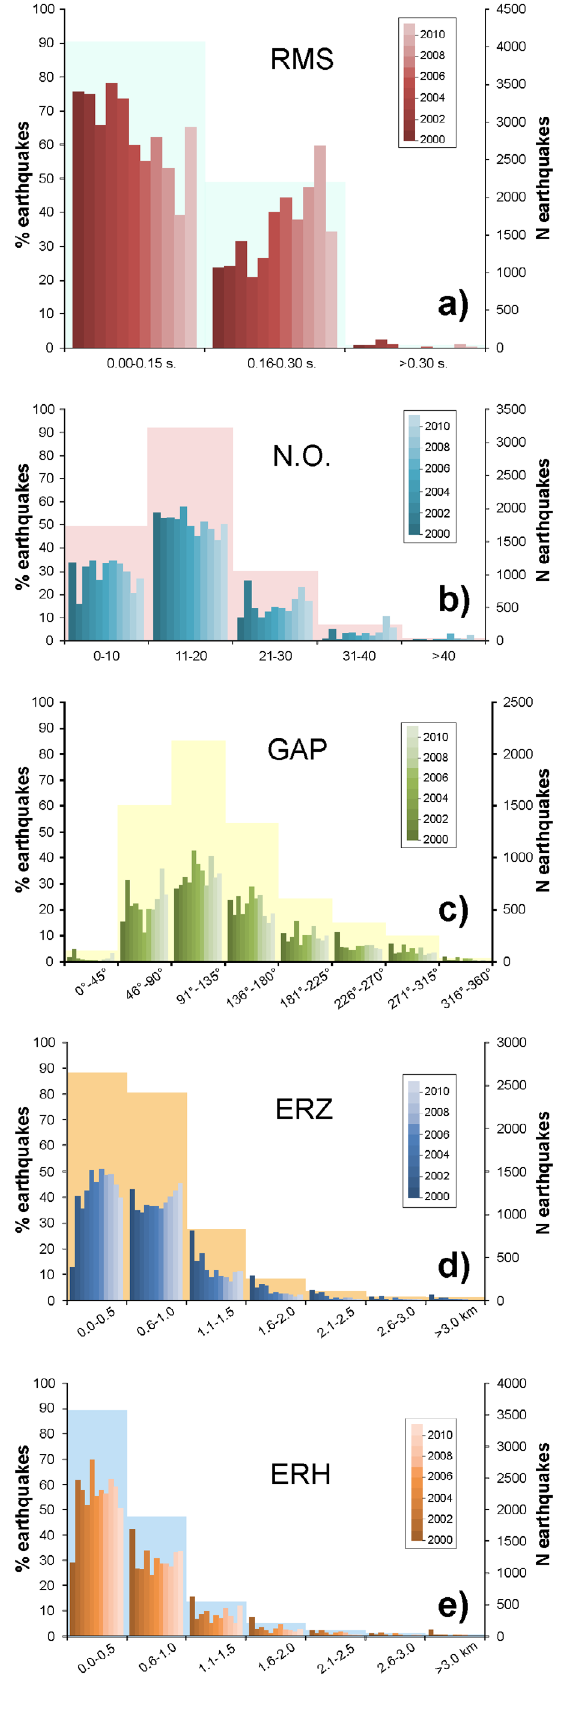
Figure 12. Temporal evolution of the hypocentral parameters as- sociated to seismic location during the analyzed period: (a) RMS; (b) N.O.; (c) GAP; (d) ERZ; (e) ERH. See the text for further